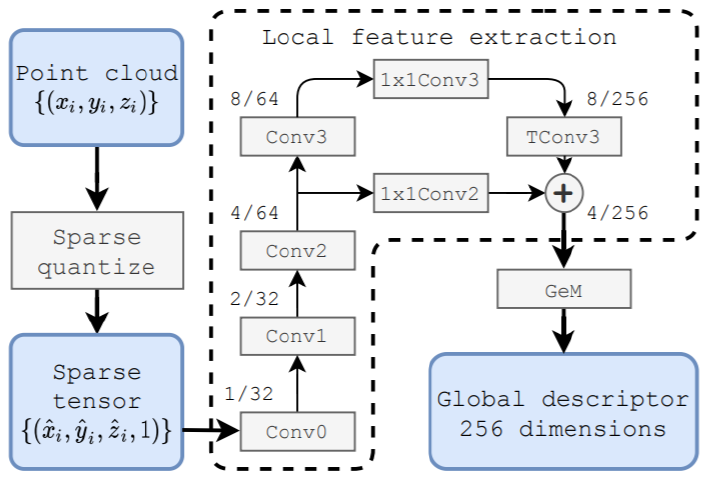
Figure 35. The network of MinkLoc3D [87] for point-cloud-based place